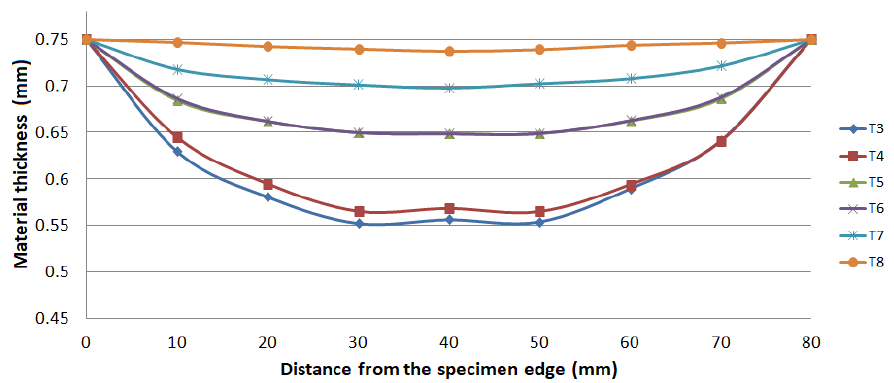
Figure 9. Material thickness values in 90° direction after bulge test.